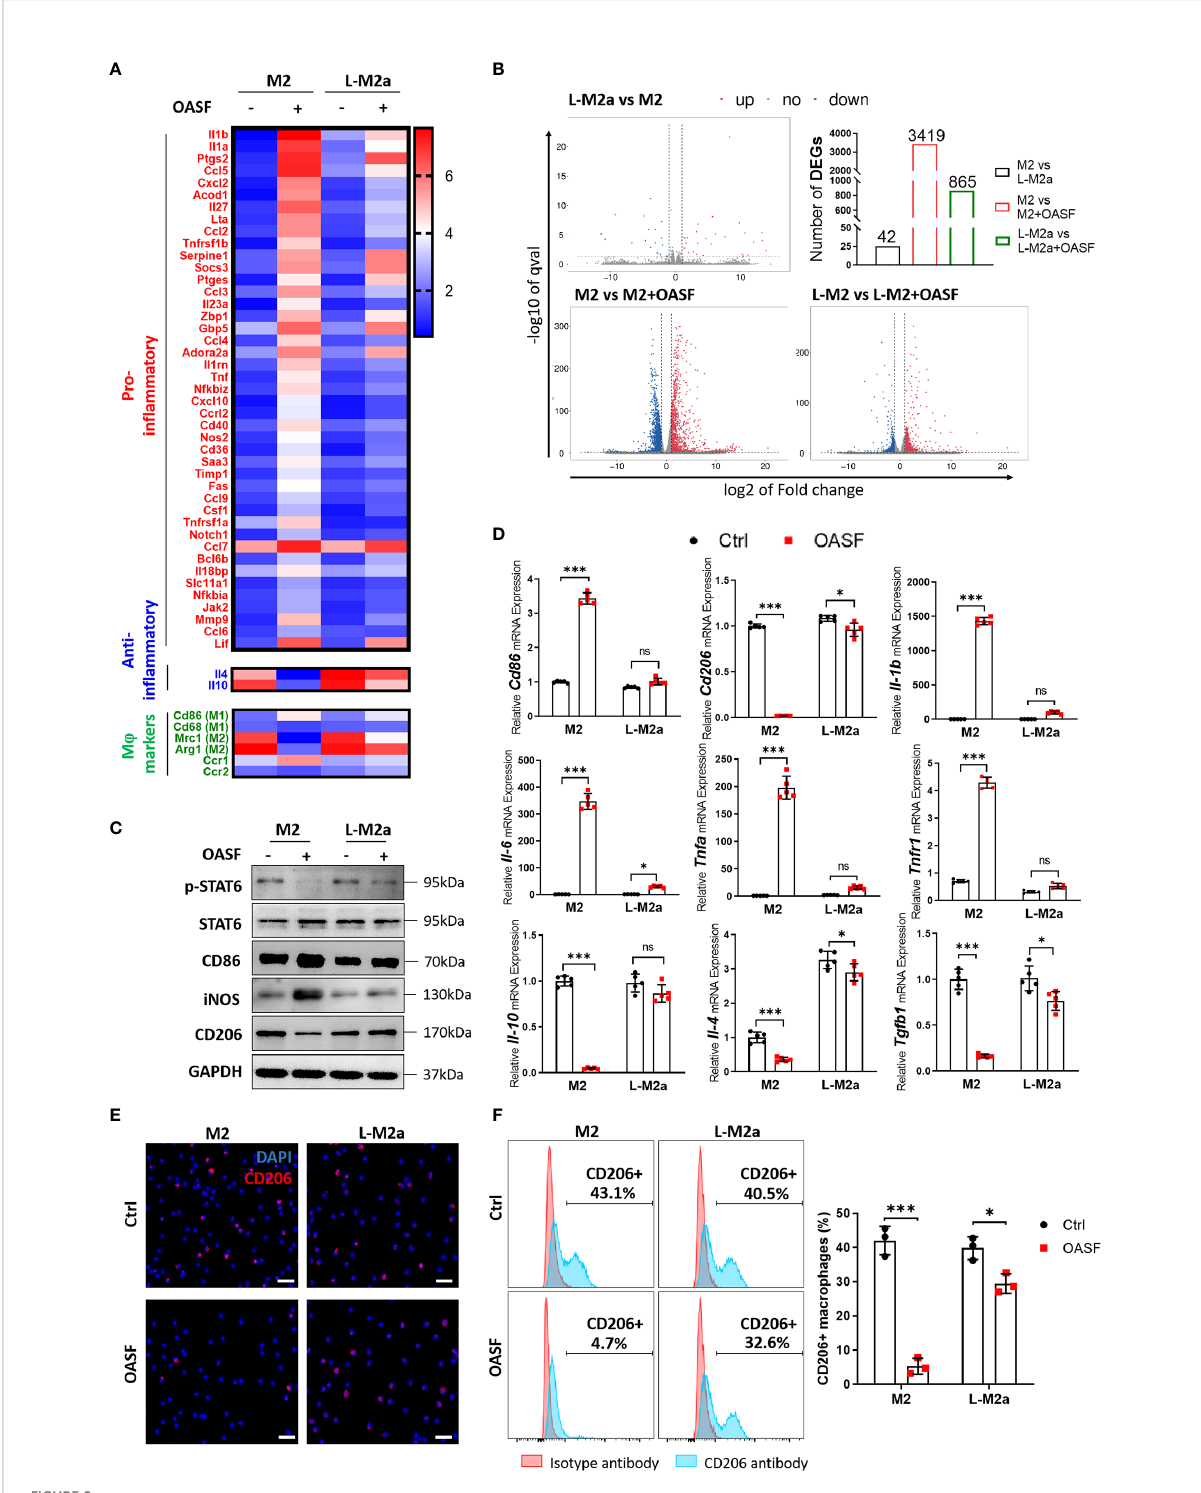
FIGURE 2 L-M2a M j s maintained a more stable polarization in the presence of OASF in vitro . (A, B) A heatmap about in fl ammatory related transcriptome changes (A) and number of differentially expressed genes (B) among M2 and L-M2a macrophages treated with or without OASF by RNA sequencing (n=3). (C, D) Validation of expression level of saveral typical genes in (A) using western blot (C, n=3) and RT-qPCR (D, n=5). (E, F) Expression of M2 maker CD206 in M2, and L-M2a M j when stimulated with or without OASF by immuno fl uorescence (E, bar= 100 m m) and fl ow cytometry (F) . ∗ p < 0.05; ∗∗∗ p < 0.001. ns, no signi fi cance; M j , macrophage; L-M2a M j , locked M2a macrophage; OASF, OA synovial fl